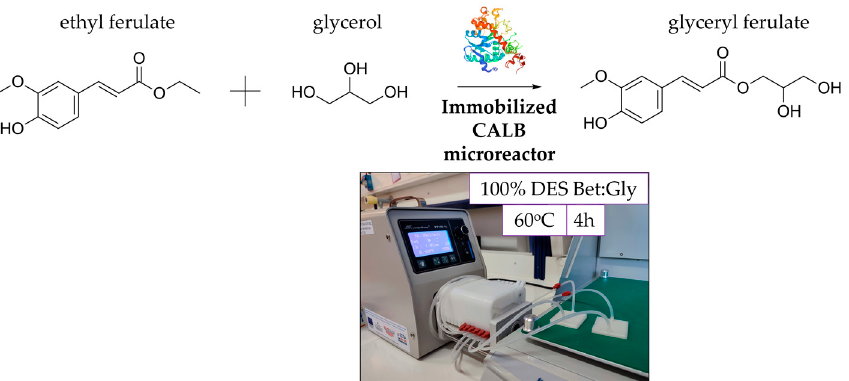
Figure 11. Reaction scheme for the transesterification of ethyl ferulate with glycerol in 100% Bet:Gly